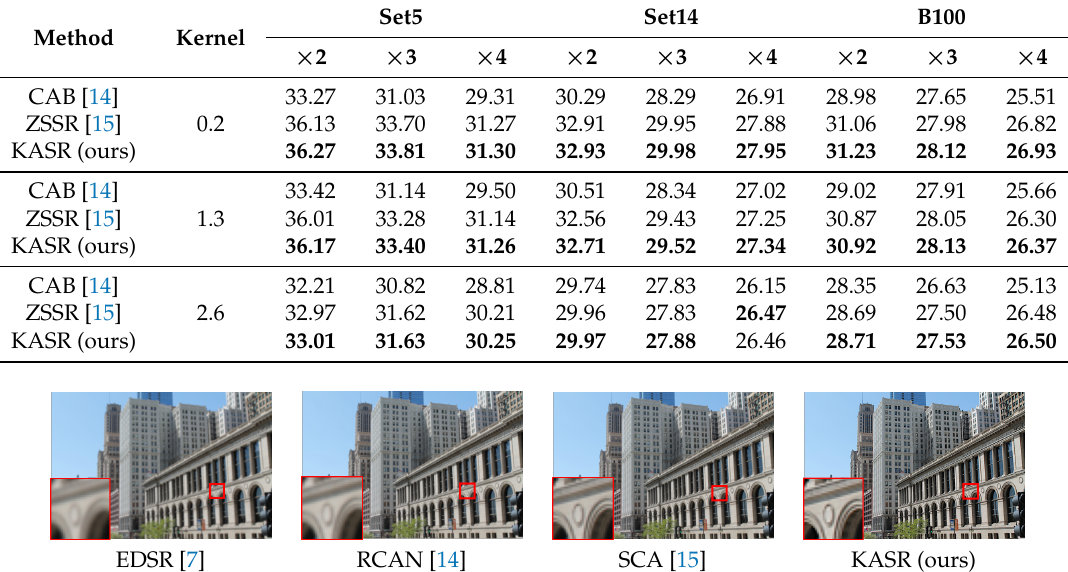
Figure 5. SR visual result comparison of different methods with SR factor 4 and kernel width 1.6 on image “Img − 97” from